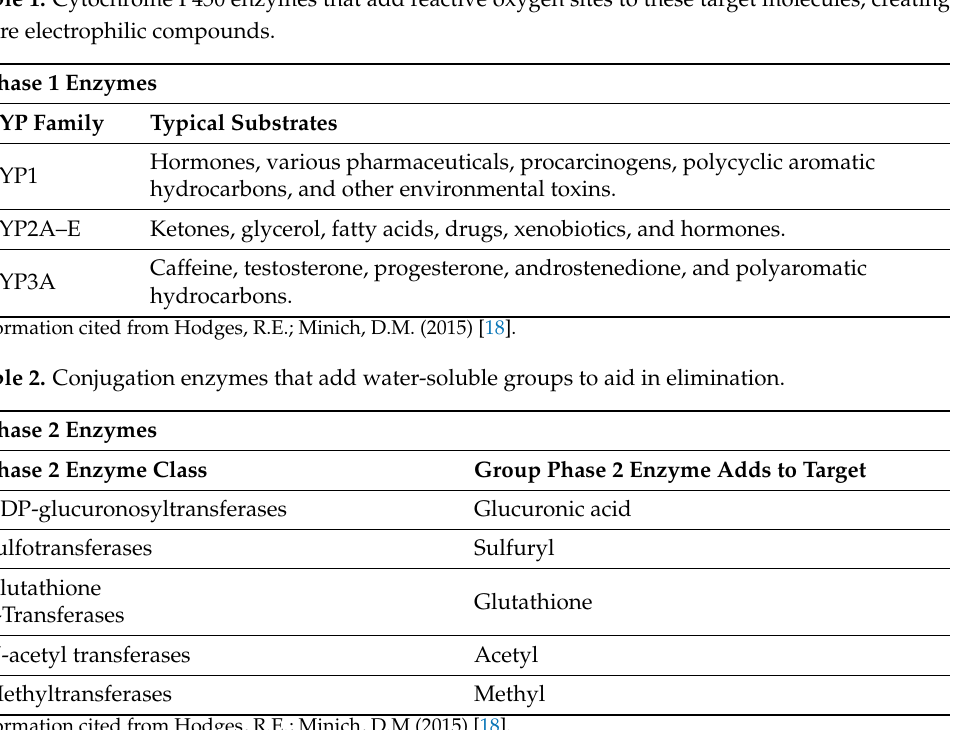
Table 1. Cytochrome P450 enzymes that add reactive oxygen sites to these target molecules, creating more electrophilic compounds.